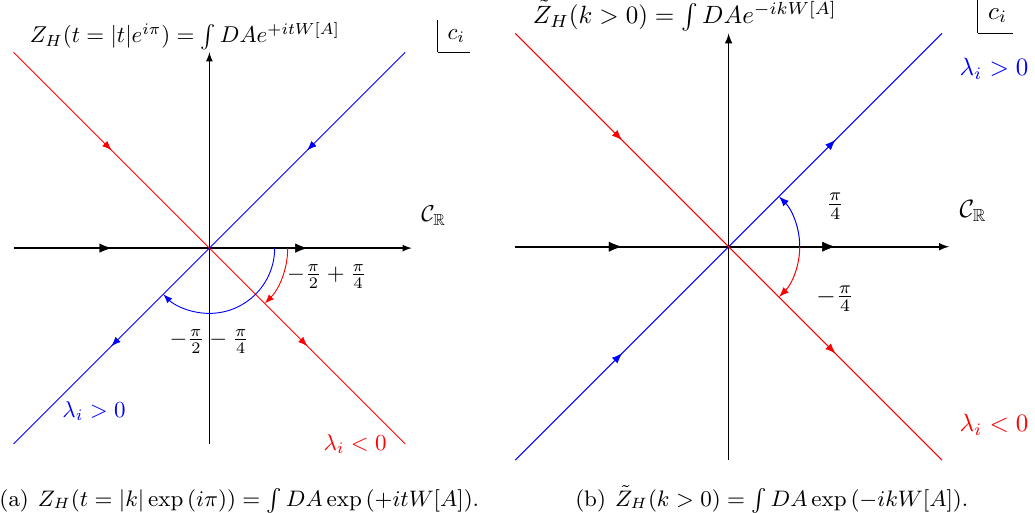
i(cid:25) ) VS. ~ Z H ( t = j k j e H ( k >